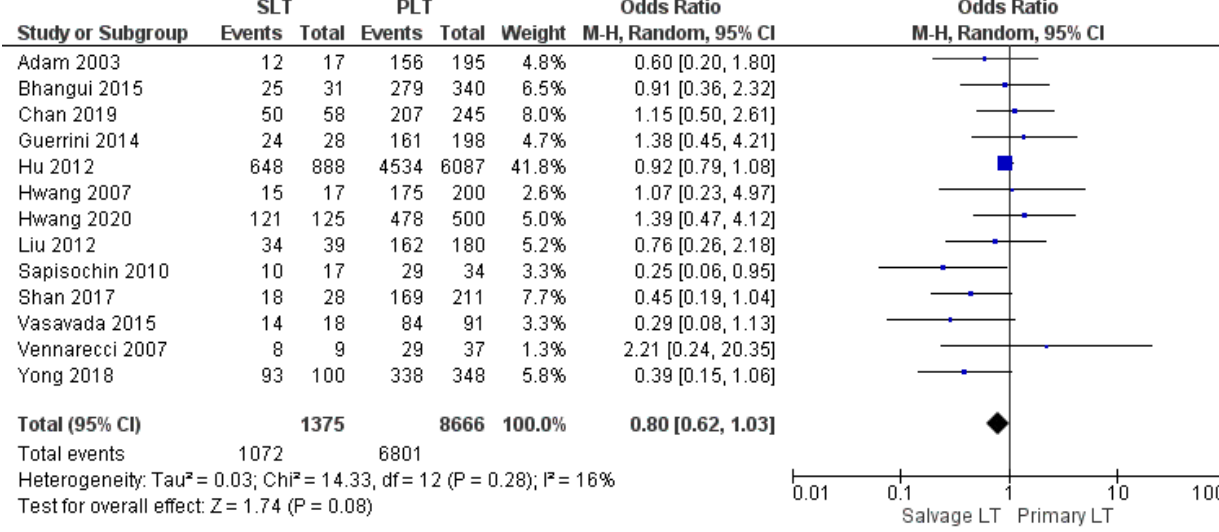
Figure 16. 1 - year overall survival rates.